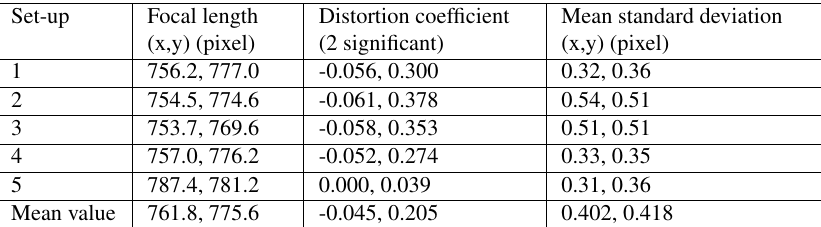
Table 1. Geometric calibration